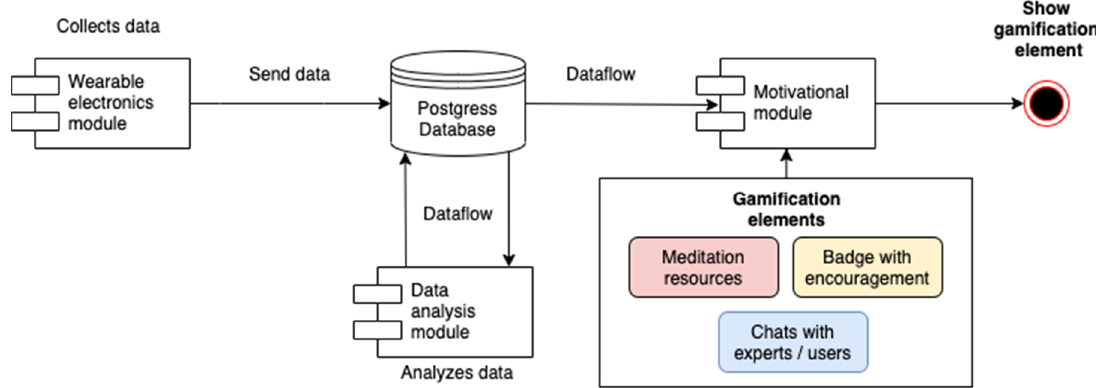
Figure 23. Gamification element selection based on wearable electronics data.